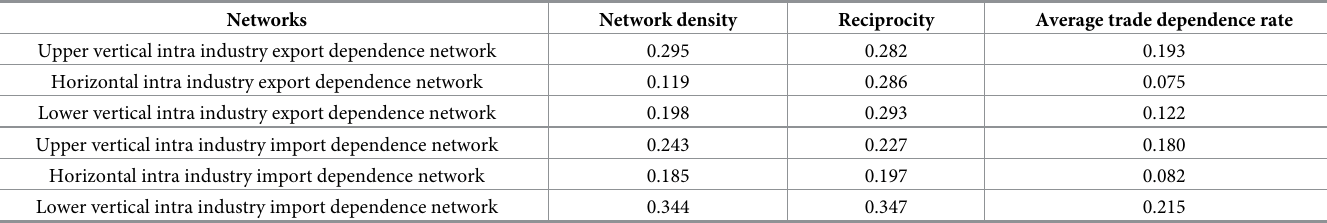
Table 2. Descriptive statistical characteristics of China EU equipment manufacturing trade network in 2020.